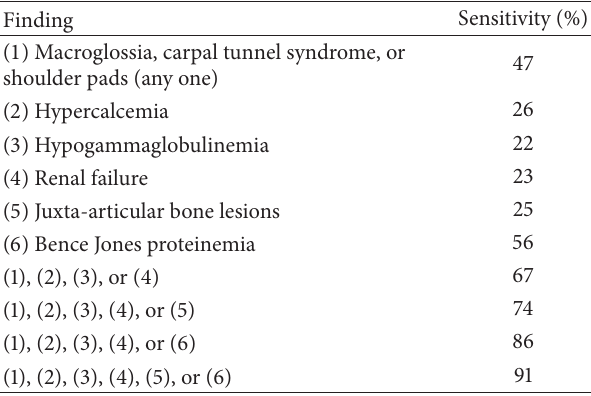
Table 1: Sensitivity of selected physical and laboratory findings for detecting amyloidosis in the setting of multiple myeloma